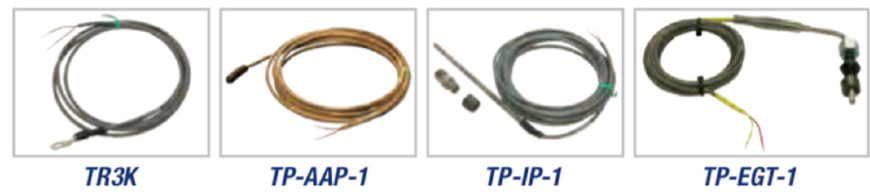
Figure 6. TMP100 Temperature Module [71].